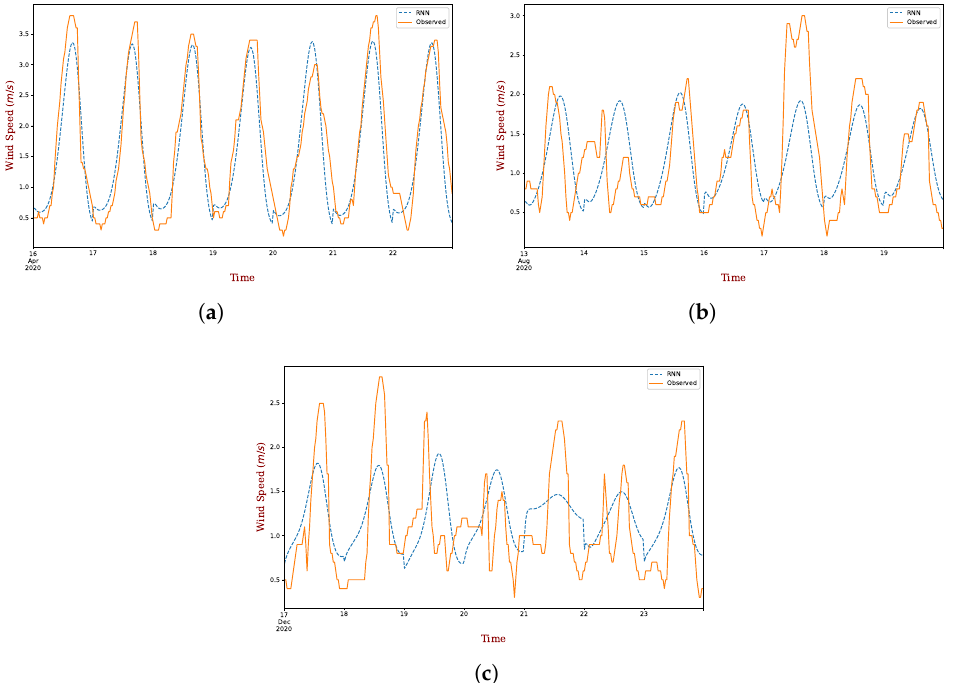
Figure 13. Wind speed prediction for three weeks of 2020 with RNN. ( a ) Week 16. ( b ) Week 33. ( c ) Week